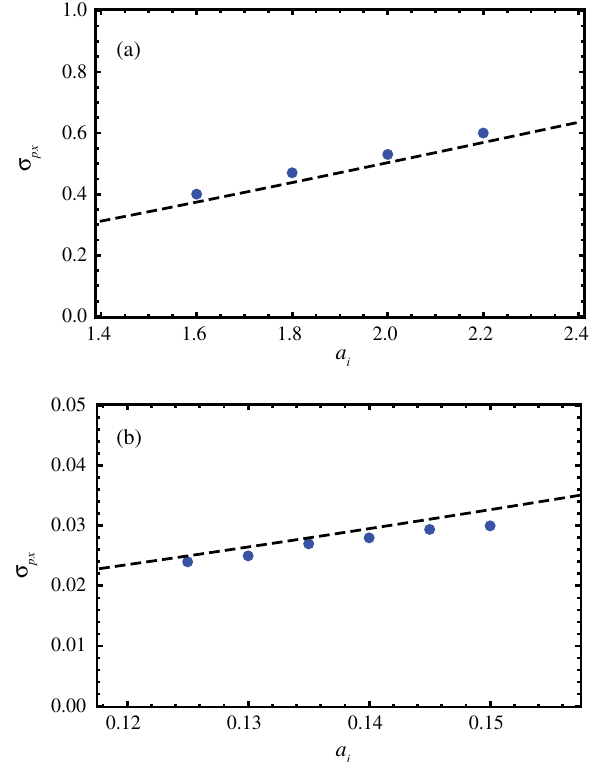
FIG. 3. The rms transverse momentum distribution versus ionization laser intensity for laser ionization injection using ¼ 0 . 8 μ m and FWHM (a) a high intensity laser pulse, with λ i ¼ 552 eV), duration 40 fs, ionizing a nitrogen gas, N 5 þ → N 6 þ ( U I in a background plasma of density 1 . 7 × 10 18 cm − 3 , and (b) a low ¼ 0 . 4 μ m and FWHM duration 16 fs, intensity laser pulse, with λ i ¼ 230 eV), in a back- ionizing a krypton gas, Kr 8 þ → Kr 9 þ ( U I ground plasma of density 2 × 10 17 cm − 3 . The points are obtained from PIC simulations, and the dashed curves are Eq. (14).